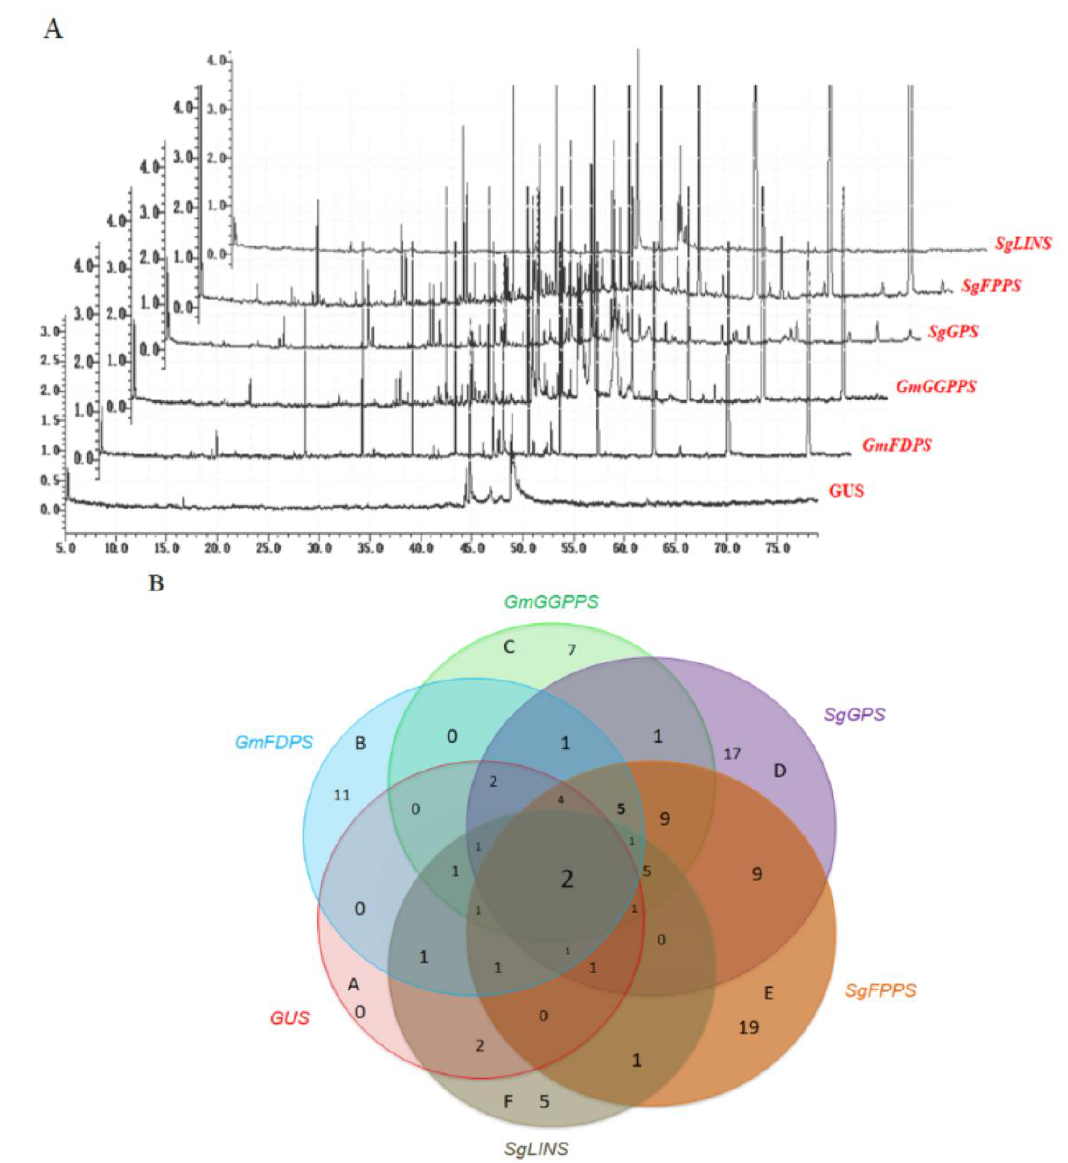
Figure 2. Typical GC-MS mass spectragraphs for terpenoids from six hexane extracts from the different overexpression of terpenoid biosynthesis genes. ( A ) GC-MS Peak of the essential oil; ( B ) Six-way Venn diagram to show the number of unique and common compounds in the essential oil extracts from GUS (A), GmFDPS (B), GmGGPPS (C), SgGPS (D), SgFPPS (E) and SgLINS (F) of G. max and S. guaranitica .